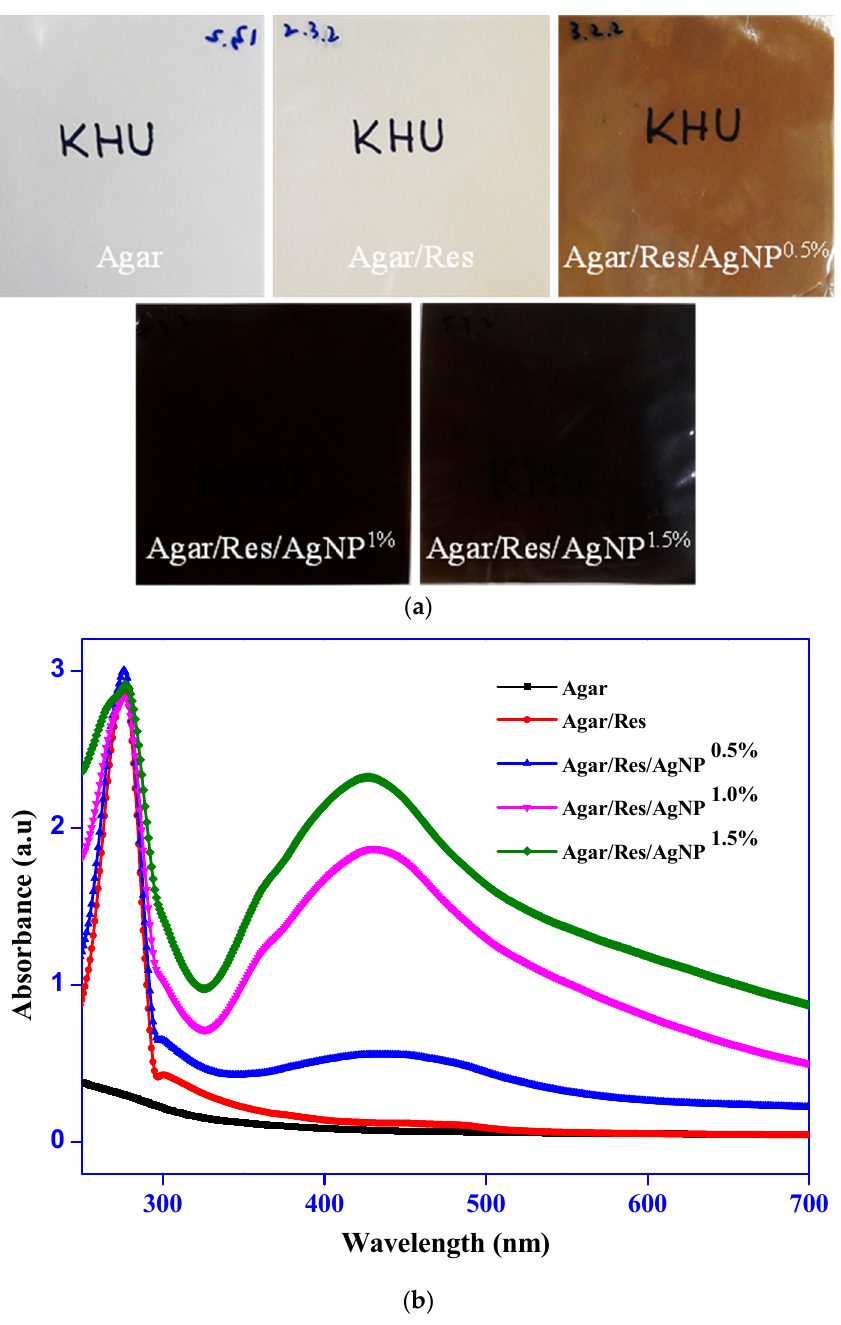
Figure 1. Appearance ( a ) and UV-visible light absorption spectra ( b ) of the agar-based composite films. Table 1. Surface color and light transmittance of the agar-based composite films.